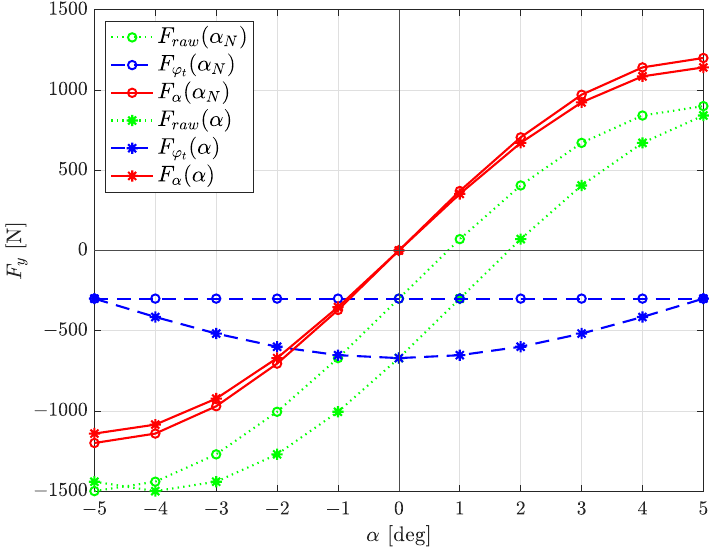
Figure 5. Effect of slip axis misalignment. Circled lines identify the tyre characteristics, and starred lines identify the same characteristics obtained with a